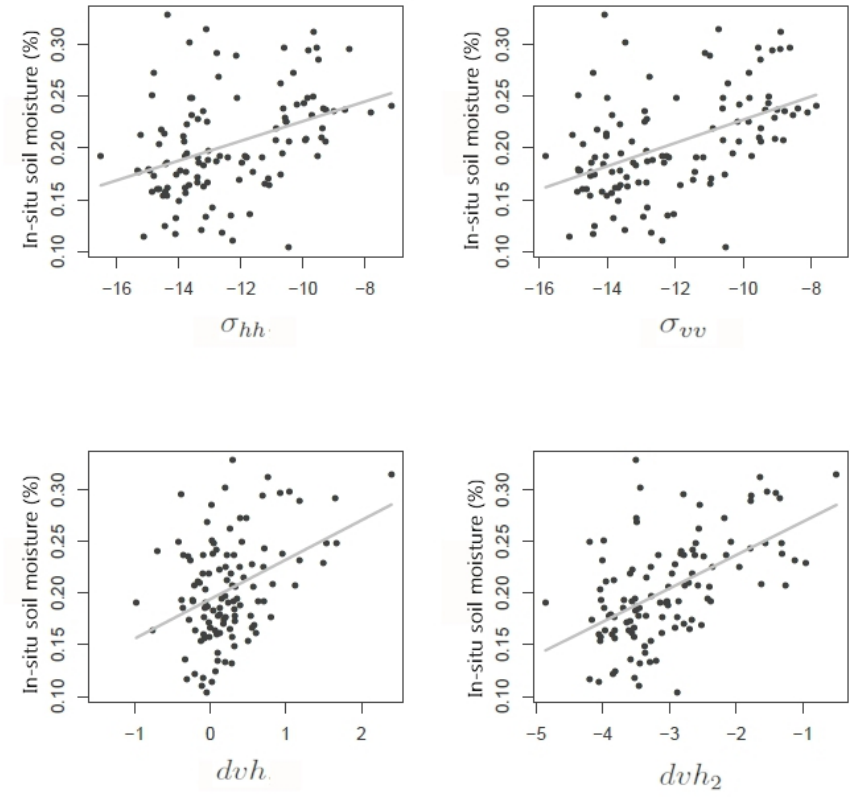
Figure 6. Scatterplots of in-situ soil moisture ( m )(%) versus horizontal and vertical backscatter coefficients, σ (lower panels). Best-fit regression lines are indicated.